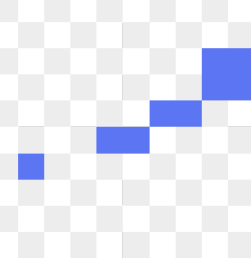
Figure 15. Grid 10 × 10 (manual — skilled operator).